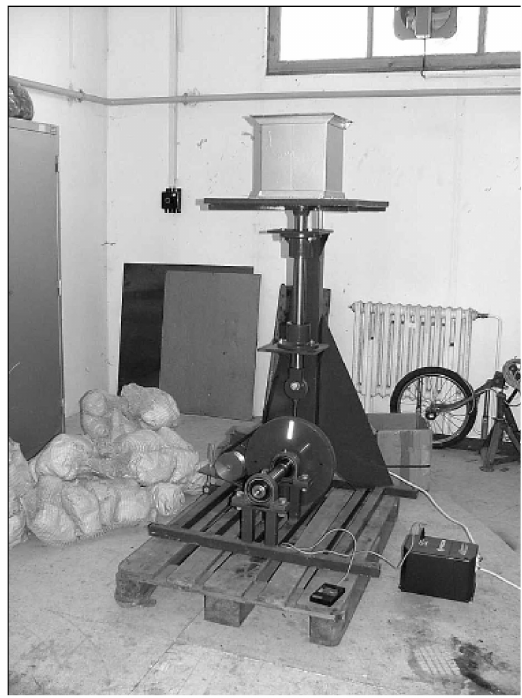
Figure 1. Testing stand of RIAE Prague for samples mechanical loading examination (mechanical loading motion